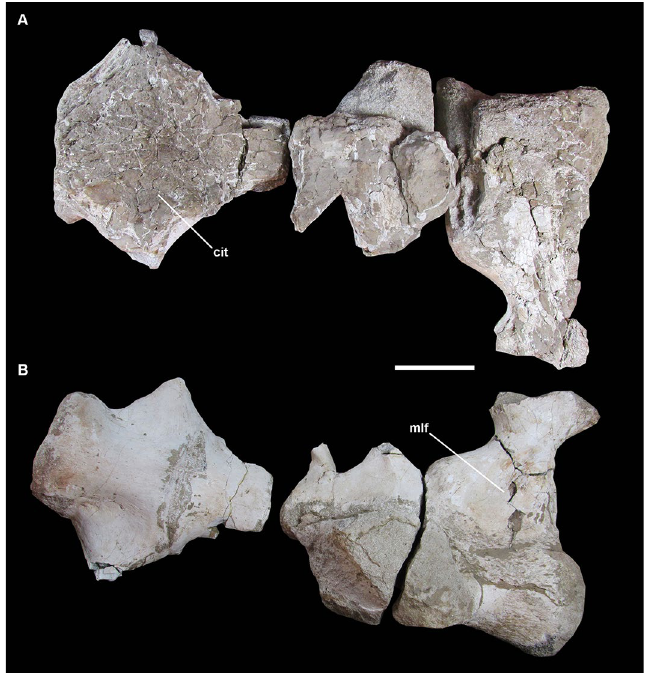
Figure 5. Sacral vertebrae (IVPP V27875), in ( A ) dorsal view, showing the camellate internal tissue (cit) and, ( B ) in ventral view, showing the mediolaterally deep fossa (mlf) on the ventral surface. Scale bar: 10 cm.